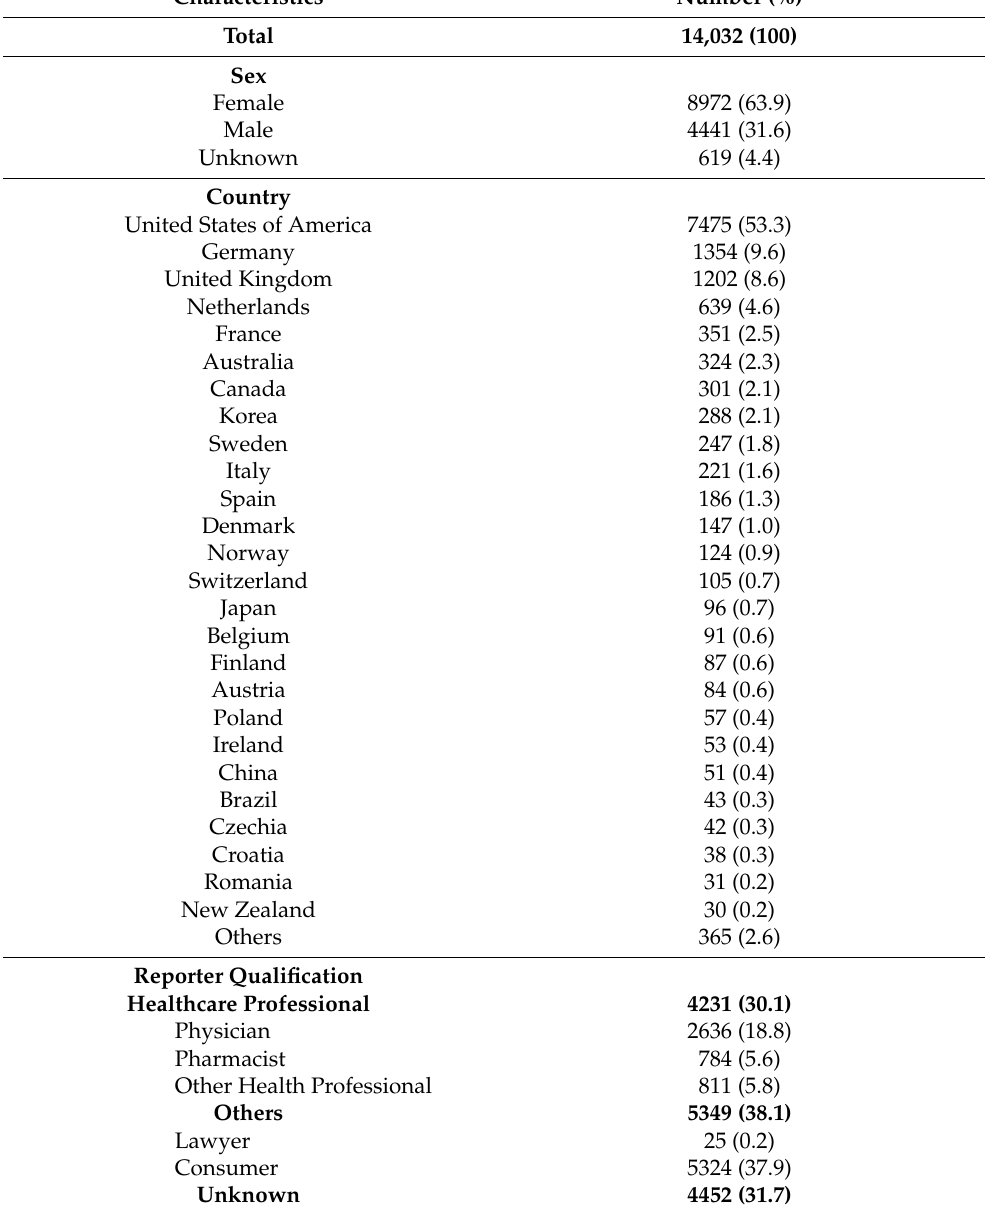
Table 1. Characteristics of the reports of patients with parosmia.